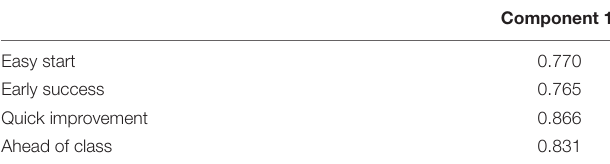
TABLE 5 | Loading table–EFA pattern matrix, “early success”.